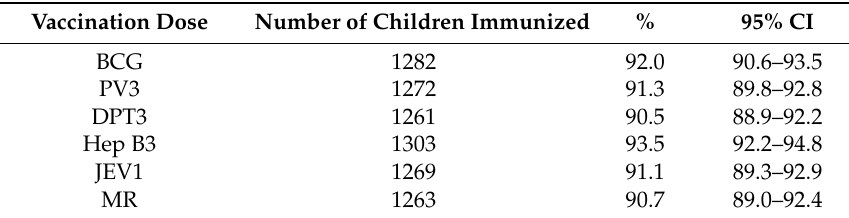
Table 2. Vaccination coverage among the surveyed children with immunization cards (N = 1393). Vaccination